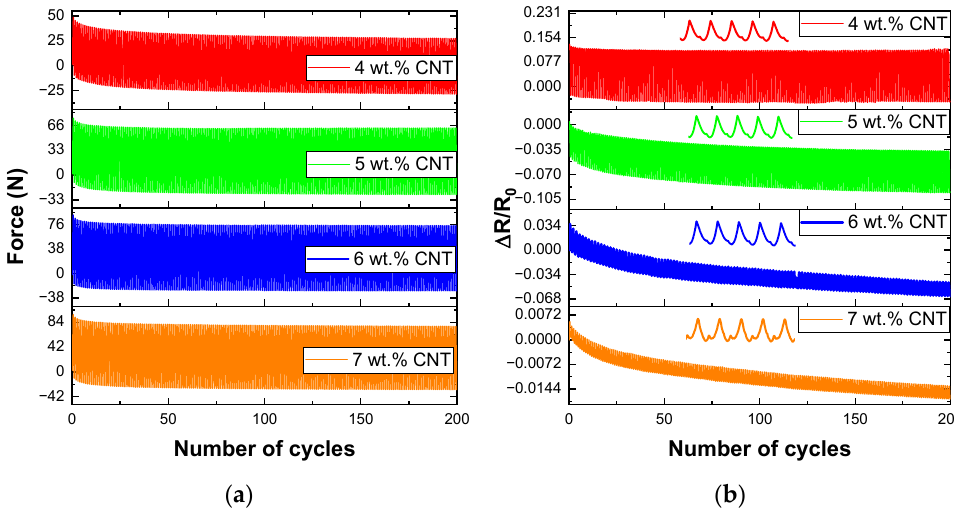
Figure 7. Cycling response of nanocomposites at 1% strain levels. ( a ) mechanical and ( b ) electrical response under 300 cycles. A detail of 150–155 cycles is shown in electrical response. Table 1. Values of the mechanical and self-healing properties for neat Surlyn and CNT–Surlyn nanocomposites. Neat 4 wt.% CNT 5 wt.% CNT 6 wt.%